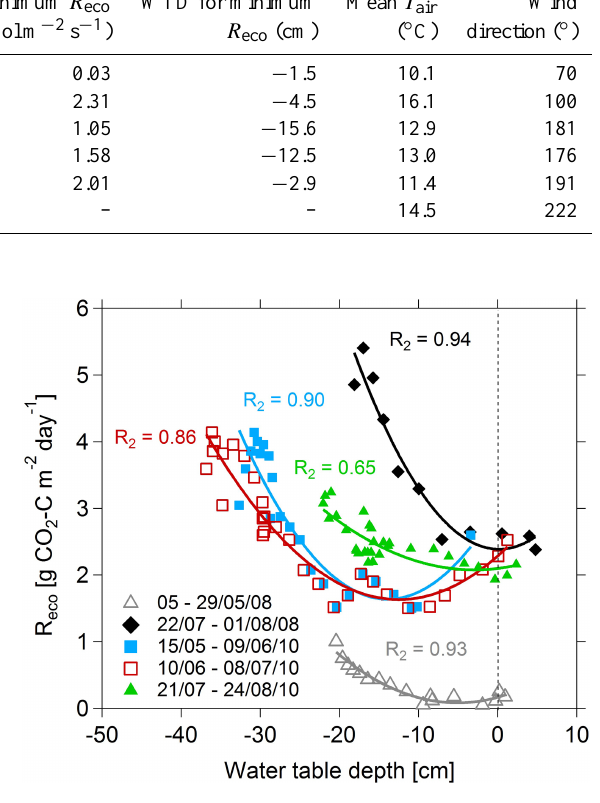
Figure 6. Spring/summer fluxes of NEE, GPP and R eco (mean from April to September) as a function of the preceding winter’s mean air temperature (mean from December to March).